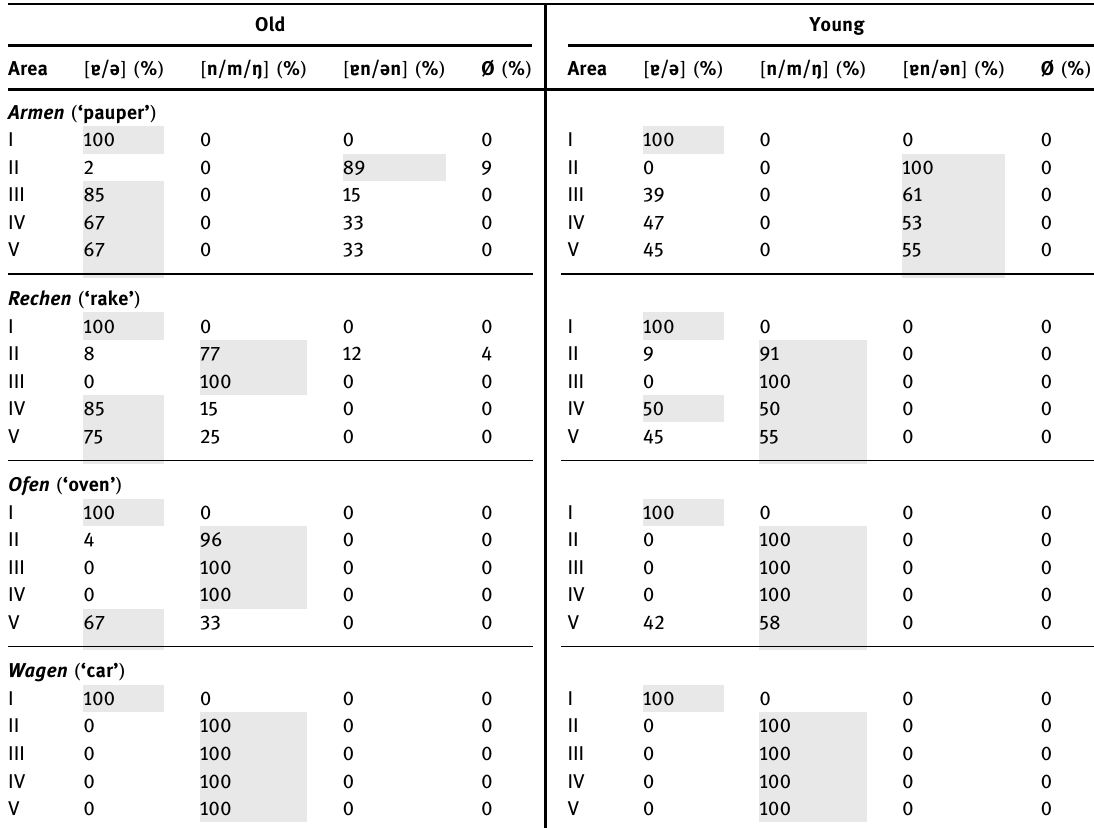
Table 4: Results for ( en ) in nominal forms